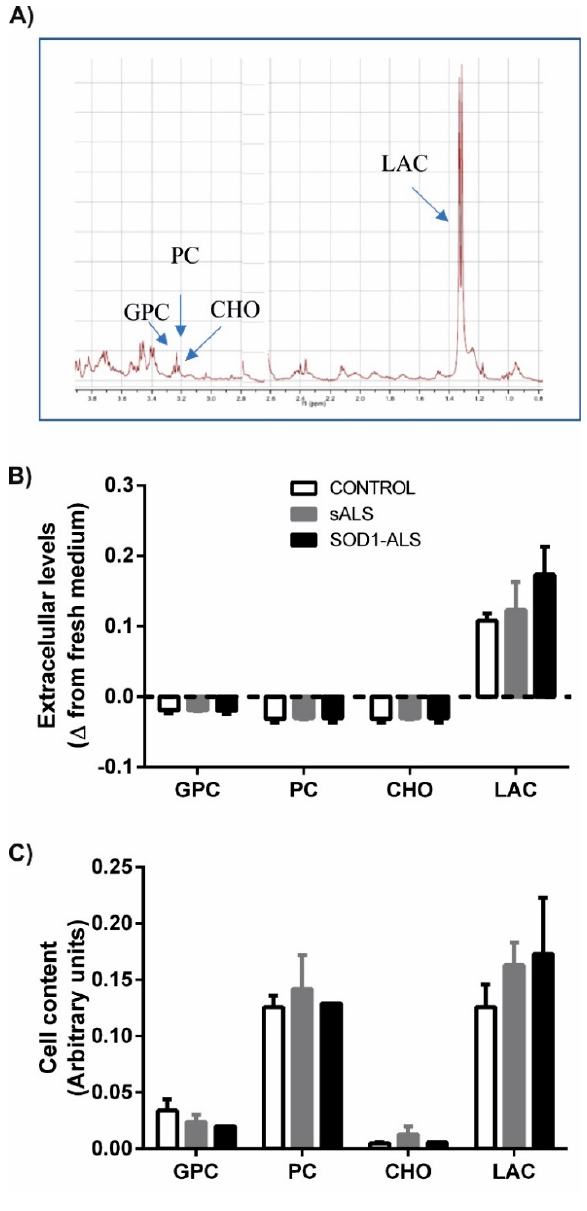
Figure 2. Metabolic profiles of lymphoblasts from healthy subjects, and sporadic or SOD1 mutation carriers ALS patients. ( A ) Representative spectrum of 1H nuclear magnetic resonance. The peaks of the metabolites of interest are marked with arrows: GPC, PC, CHO and LAC. Abbreviations: GPC, glycerol phosphocholine; PC, phosphatidylcholine; CHO, choline; DMSO, dimethyl sulfoxide; LAC, lactate. ( B , C ) Lymphoblasts (pool of 4 individuals) of controls, patients with sALS and SOD1 -ALS were incubated for 24 h in RPMI medium containing 10% FBS. The cell pellets and extracellular medium were collected after centrifuging at 10,000 rpm for 10 min and metabolites were determined by 1H NMR spectroscopy. The changes in the concentrations of the different metabolites in cell medium ( A ) or changes in intracellular content ( C ) medium are shown. All values are means ± SEM of 4 experiments, except when SEM is not indicated because only two measurements were available.